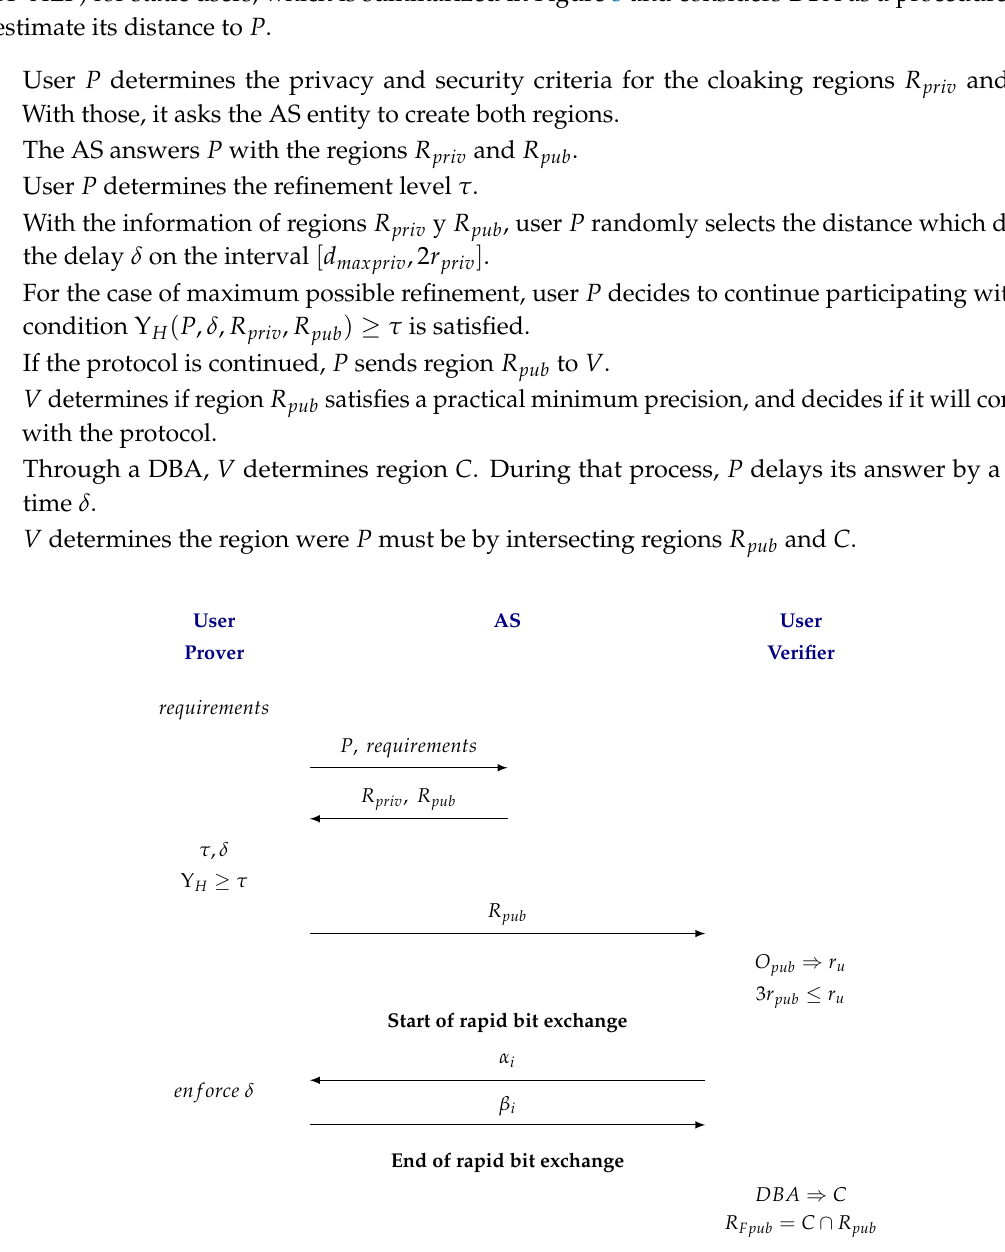
Figure 3. Distance Bounding Protocol Aware of Location Privacy (DBP-ALP) for static users. AS: trustworthy